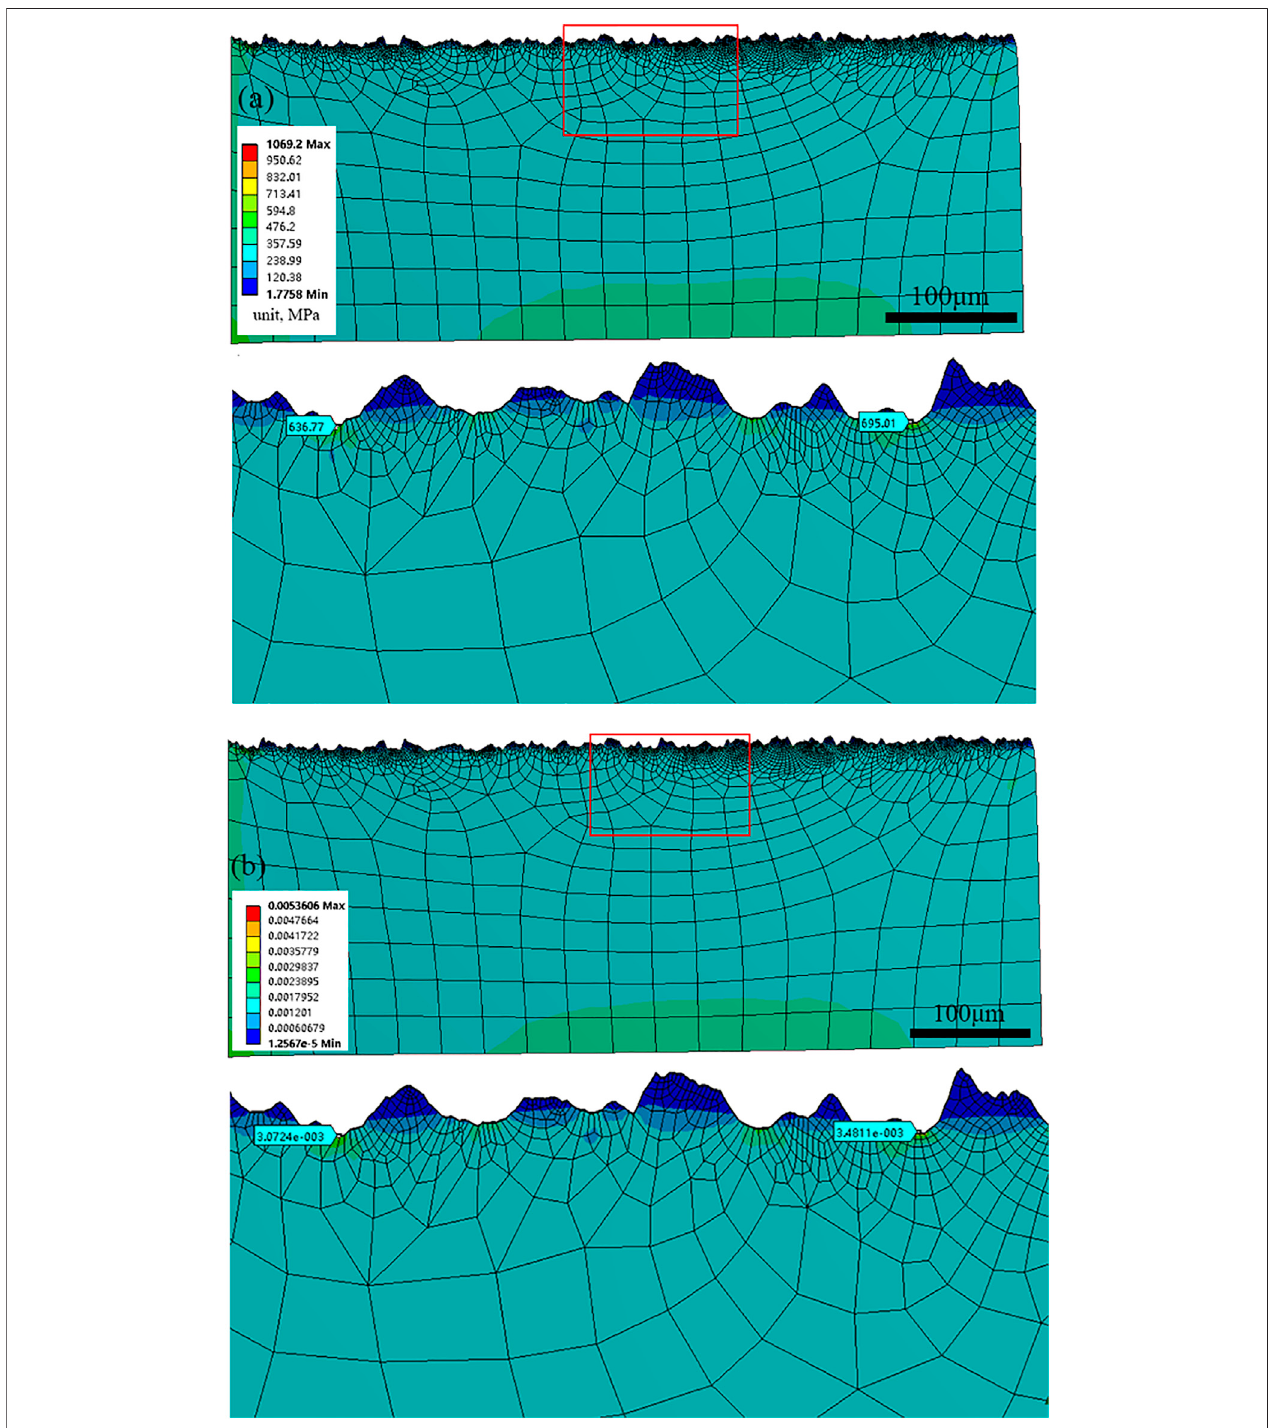
FIGURE 12 | (A) stress and (B) strain distribution of the surface after LA immersion at 120 ° C/3.2 MPa.